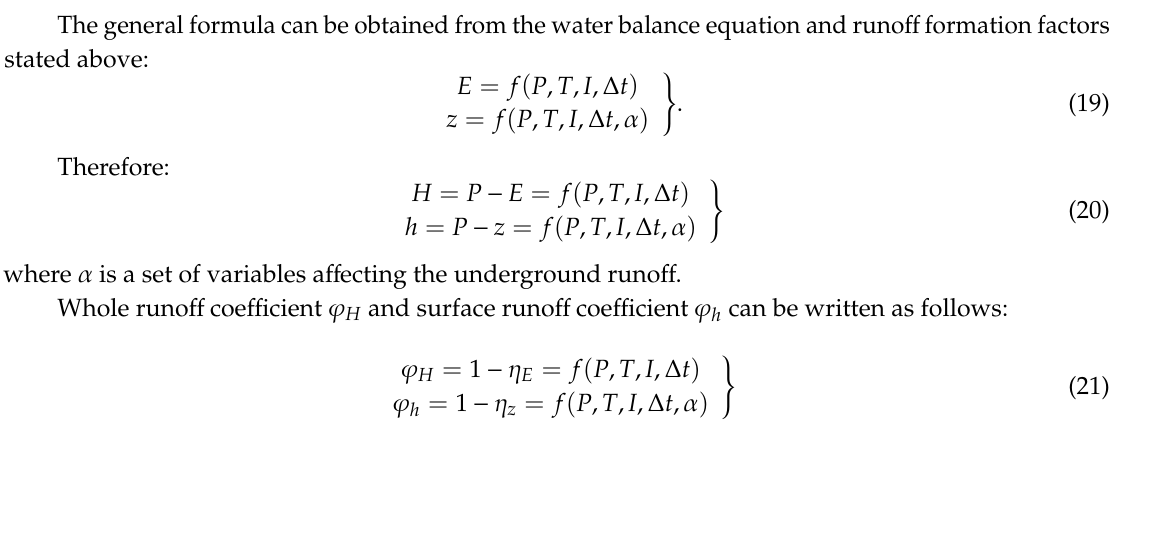
in DPR η in DPR Korea. 2 Δ 2 z